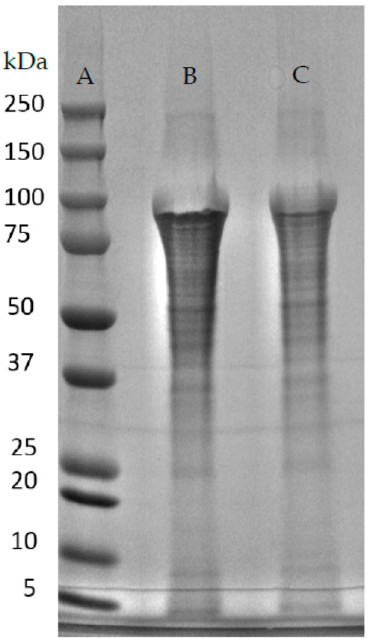
Figure 4. SDS-PAGE of Parr vessel temperature and pressure solubilization of rMaSp2 (predicted 98.7 kDa). ( A ) Bio-Rad Dual Color prestained protein molecular weight marker (MW listed to the left); ( B ) Soluble rMaSp2 at 135 °C and 140 psi; ( C ) Soluble rMaSp2 at 130 °C and 131 psi.